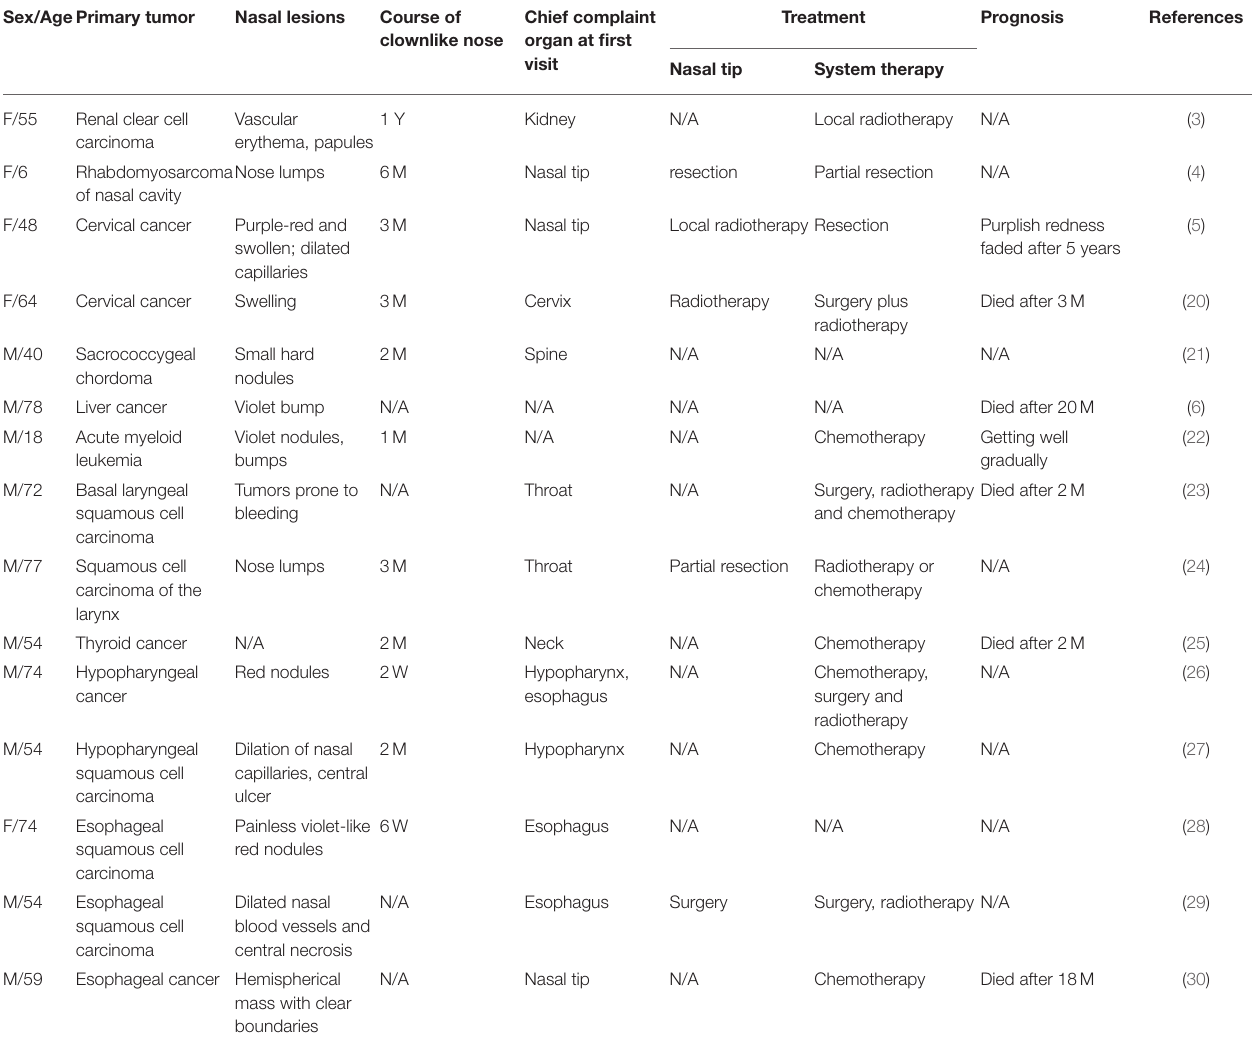
TABLE 2 | Nasal tip cutaneous metastasis from other carcinomas. Sex/AgePrimary